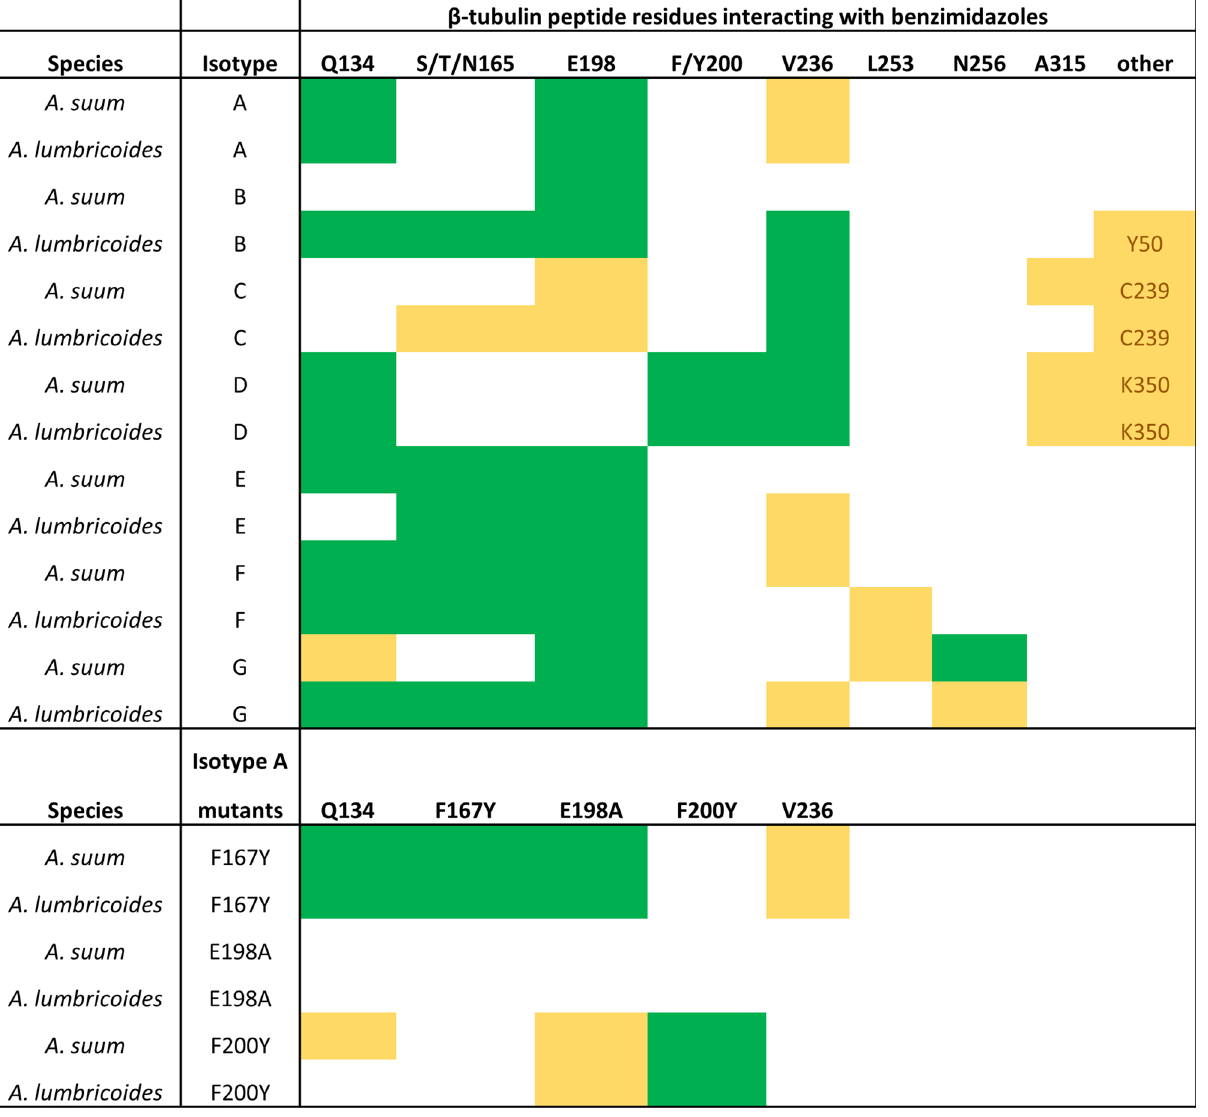
Figure 3. Ligand docking amino acid binding frequencies. The amino acids in Ascaris lumbricoides and Ascaris suum that form bonds with benzimidazole drugs in the ligand docking simulations are shown. Green represents an amino acid that interacts with more than one drug and yellow represents an interaction seen only